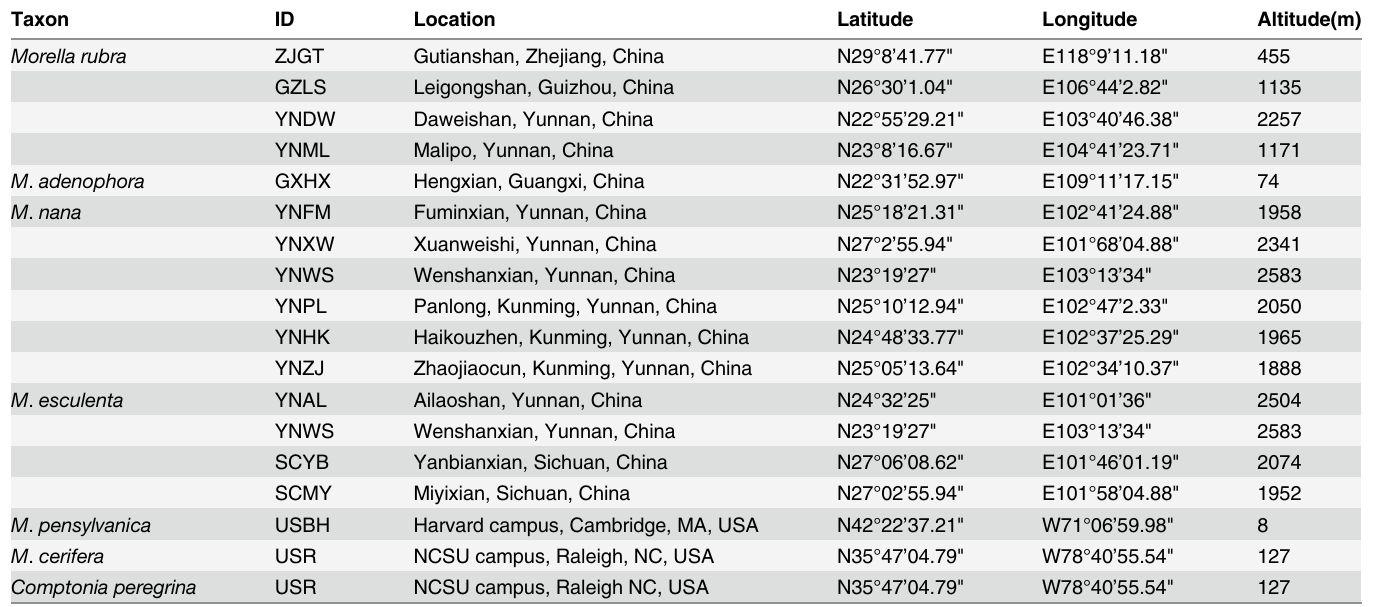
Table 1. Details of location and sampling information for species of Morella investigated in this study.